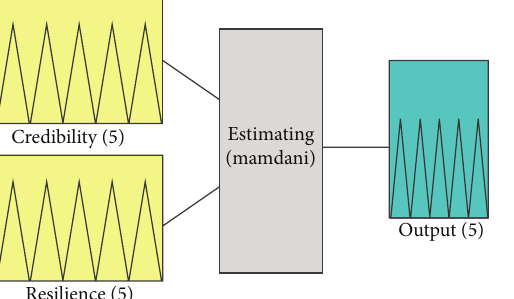
Figure 6: Proposed fuzzy inference system.